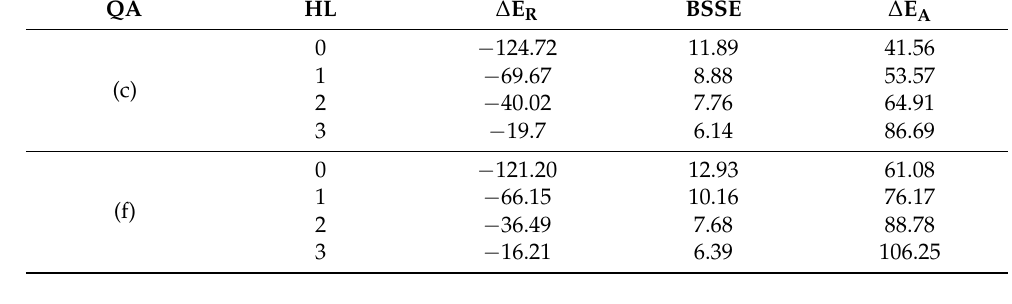
Table 2. Values of the computed ∆ E R and ∆ E A for the S N 2 degradation reaction mechanisms of QA head groups (c)/(f). Unit: kJ/mol (see Table S2 in the Supplementary Materials for detailed contributions to the results shown here).